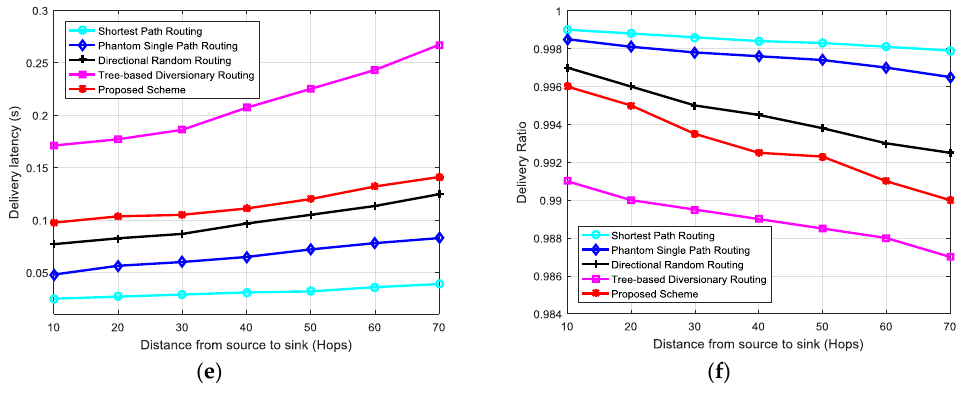
Figure 7. Simulation performance of proposed scheme, and for the shortest path routing, phantom single path routing, and directional random routing schemes. ( a ) Path diversity; ( b ) Safety period; ( c ) Attack success rate; ( d ) Energy consumption; ( e ) Delivery latency ; and ( f ) Delivery ratio.